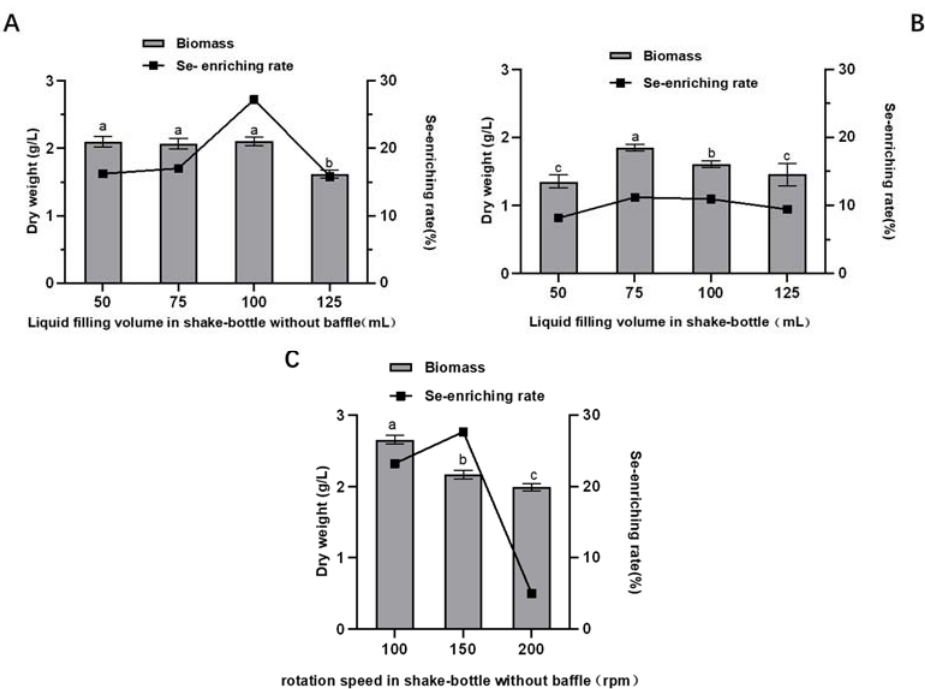
Figure 5. Effects of the liquid filling volume and rotational speed on the selenium-enriching capacity Figure 5. E ff ects of the liquid fi lling volume and rotational speed on the selenium-enriching capacity and the biomass in shake flask with or without baffle: ( A ) effect of liquid filling volume in shake flask and the biomass in shake fl ask with or without ba ffl e: ( A ) e ff ect of liquid fi lling volume in shake without baffle; ( B ) effect of liquid filling volume in shake flask with baffle; and ( C ) effect of rotational fl ask without ba ffl e; ( B ) e ff ect of liquid fi lling volume in shake fl ask with ba ffl e; and ( C ) e ff ect of speed in shake flask without baffle. Values with letters a, b and c are significantly different across rotational speed in shake fl ask without ba ffl e. Values with le tt ers a, b and c are signi fi cantly di ff erent across columns ( p < 0.05). columns ( p < 0.05).